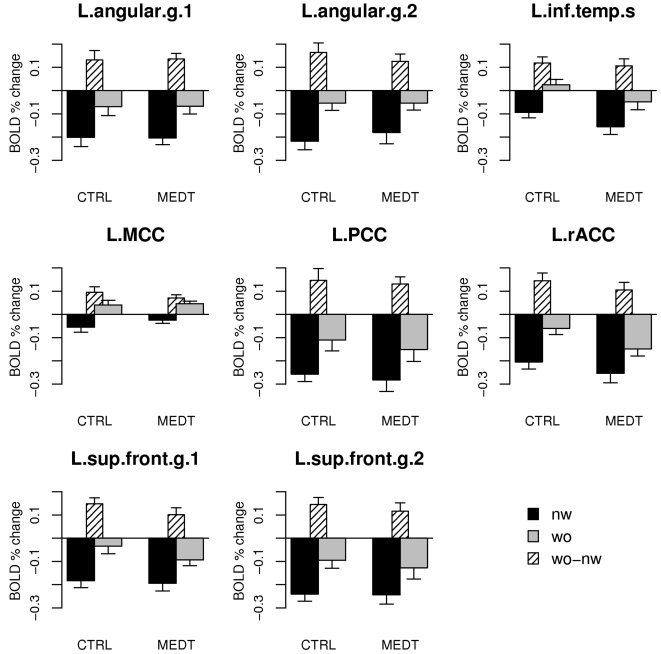
ROI-based averages of the Gamma model beta coefficients for words (“wo”) and nonwords (“nw”) in controls (CTRL) and meditators (MEDT).Abbreviations for ROI names are the same as in Table 2, where the index 1 and 2 for clusters with the same anatomical label follows the order in the table.